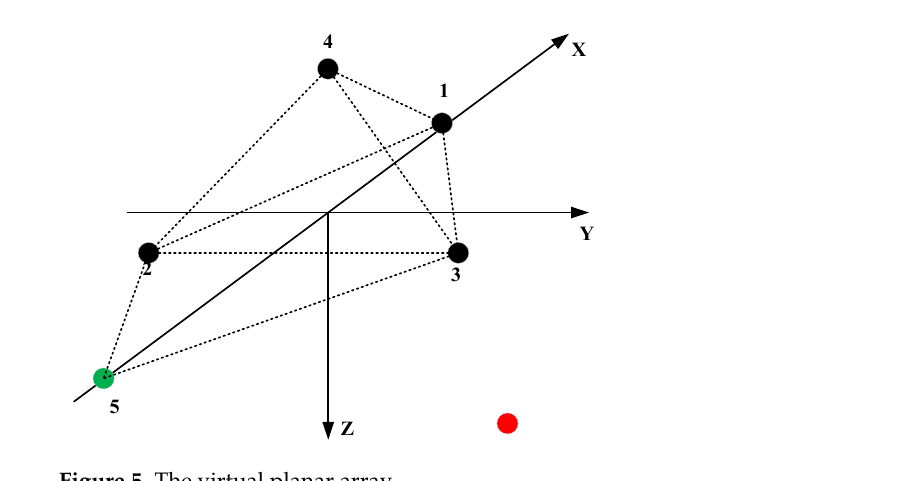
Figure 5. The virtual planar array.